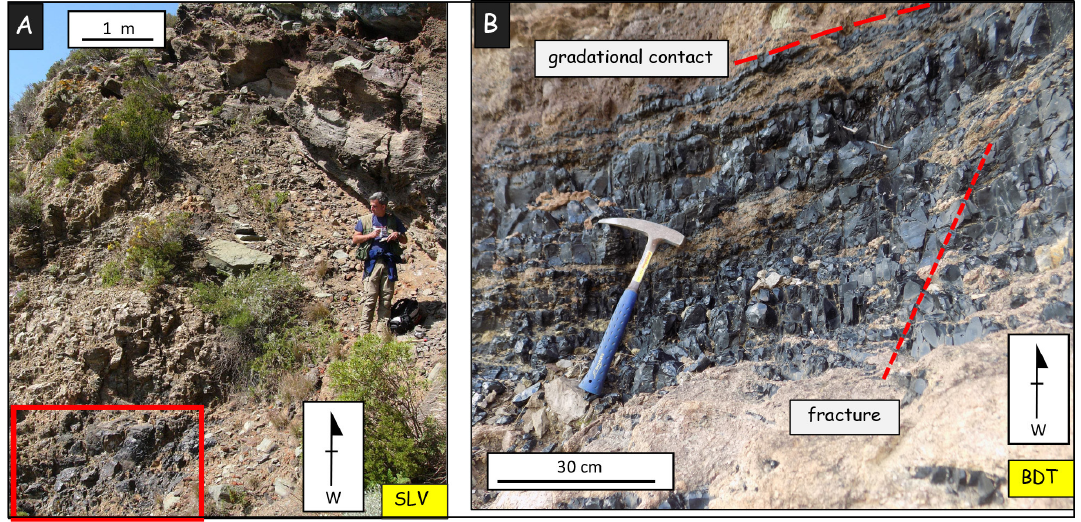
Figure 4: Field photographs displaying the obsidian outcrops. ( A ) Salto La Vecchia (obsidian in the red area); ( B ) Balata dei